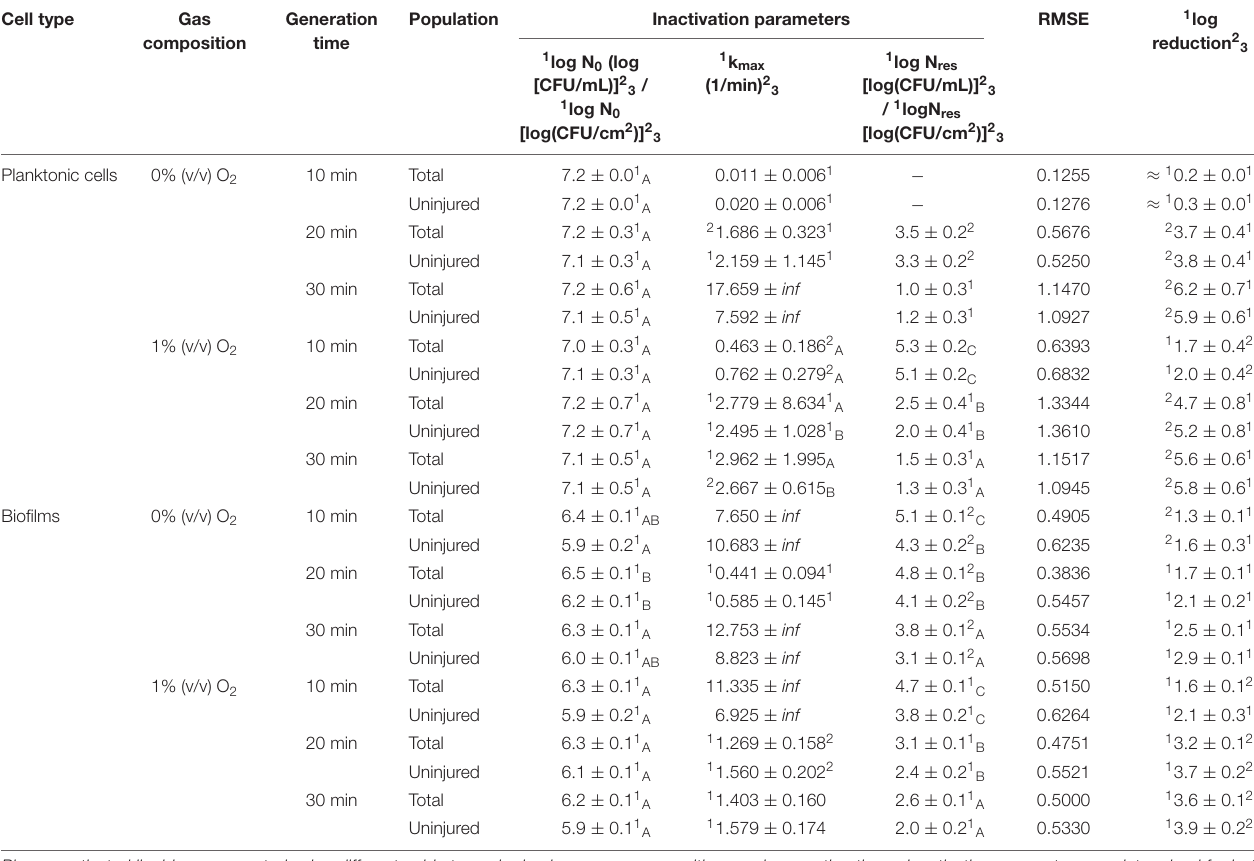
TABLE 3 | Inactivation parameters of Geeraerd et al. (2000) model for S. Typhimurium planktonic cells and biofilms after plasma activated liquid treatment. Cell type Gas composition